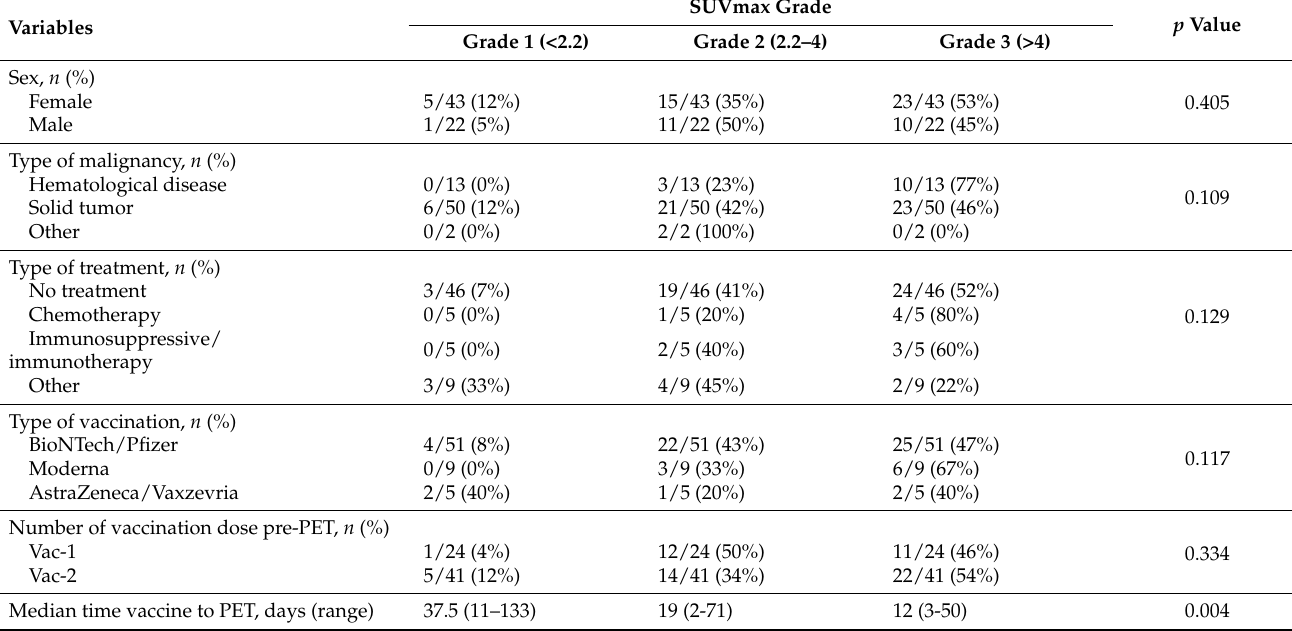
Table 4. Correlation between SUVmax grade and categorical/continuous variables in VAHL